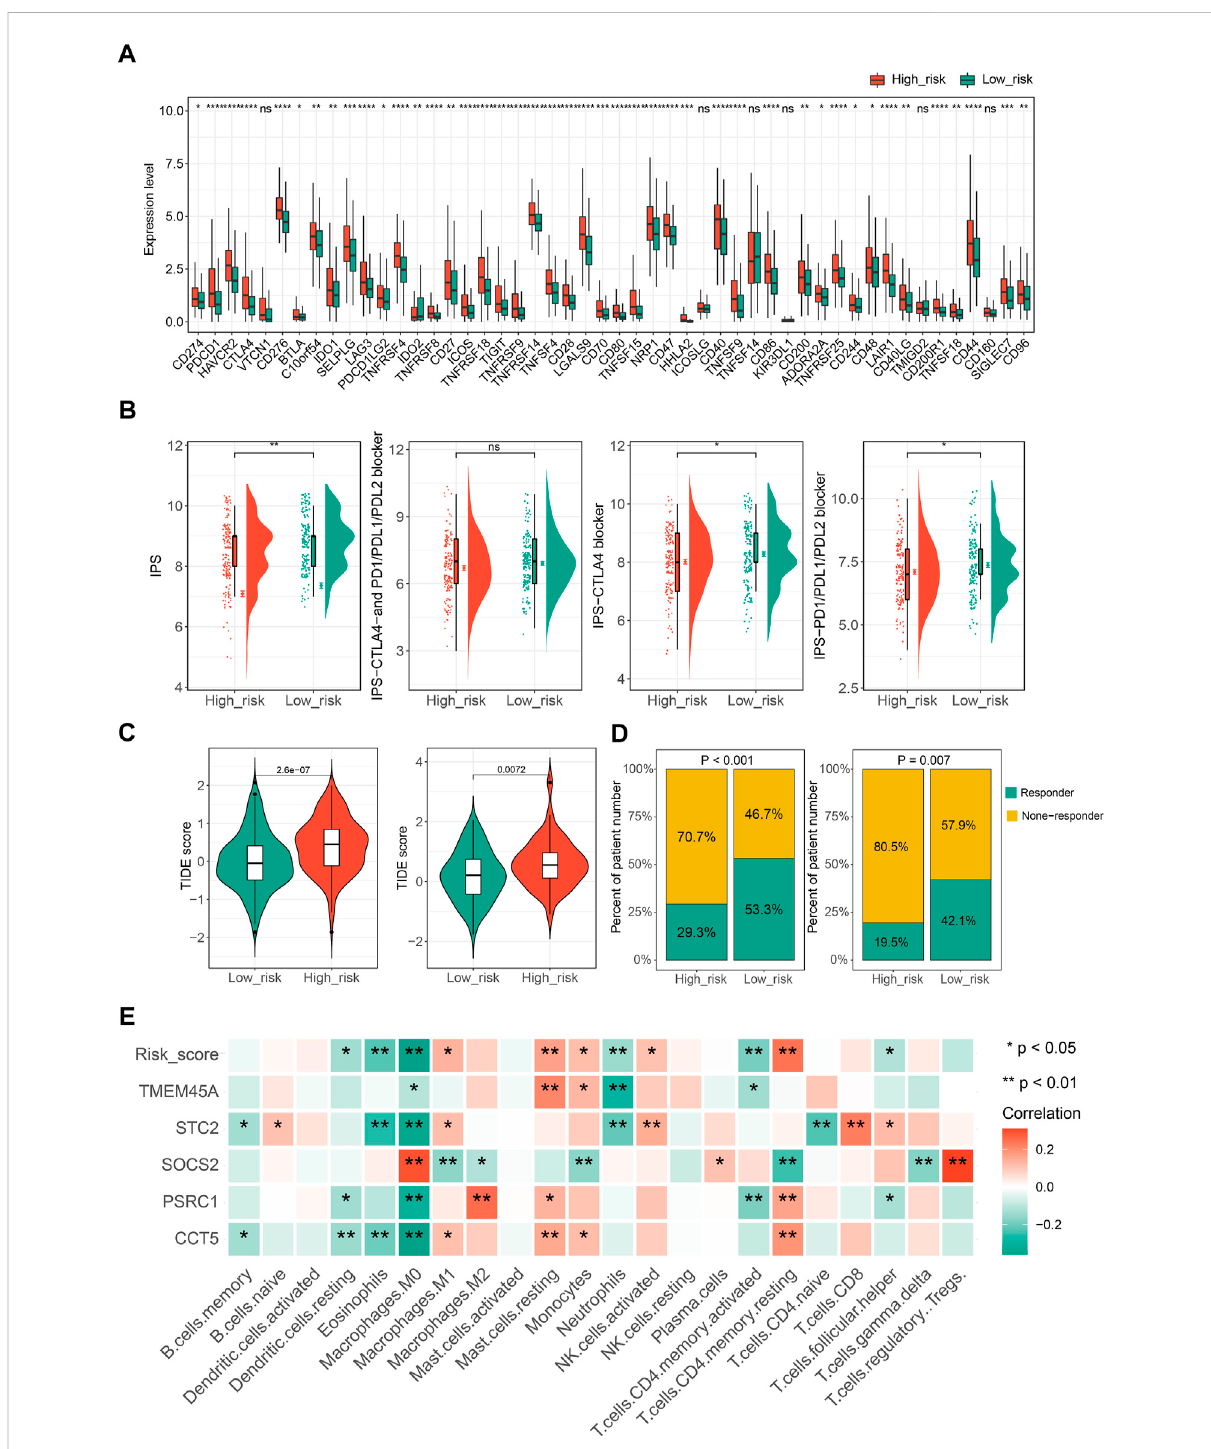
FIGURE 8 ThepotentialroleofCSGscoreinpredictingimmunotherapeuticef fi ciencyandcorrelationanalysisofCSGscoregenesandTMEcellin fi ltration. (A) The discrepancy of the gene expression of ICGs in two risk groups of the whole TCGA cohort. (B) Differences of IPS scores between the two risk groups of the whole TCGA cohort. (C) Comparison of TIDE scores between the high- and low-risk groups in thewhole TCGA cohort and the ICGC- LIRI-JP dataset. (D) The proportions of predicted responders or non-responders in the high- and low-risk groups of the whole TCGA cohort and the ICGC-LIRI-JP dataset. (E) The correlation matrix of the fi ve CSGscore genes, CSGscore, and the abundance of 22 immune cell types. * p < 0.05, ** p < 0.01, *** p < 0.001, **** p < 0.0001, and ns indicates no signi fi